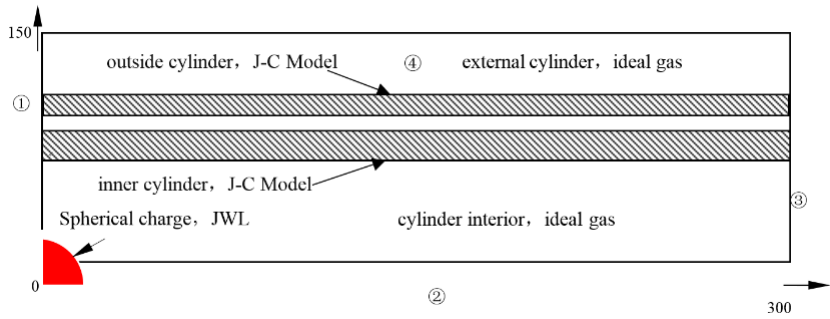
Figure 10. Two-dimensional axisymmetric model of double-layer cylinders.